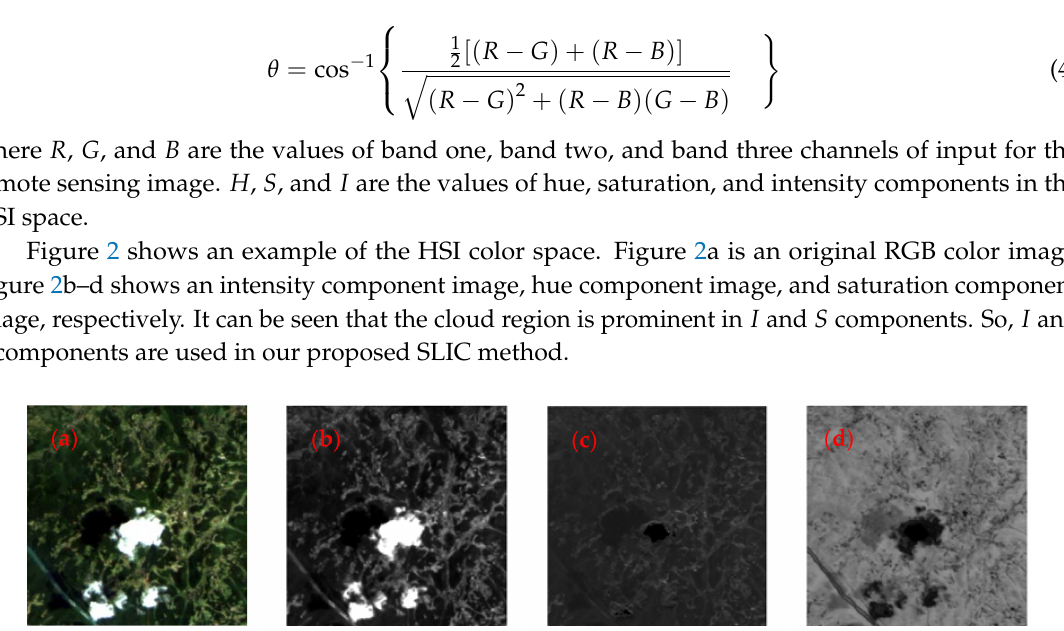
Figure 2. ( a ) Original RGB color image; ( b ) Intensity component image; ( c ) Hue component image; ( d ) Saturation component